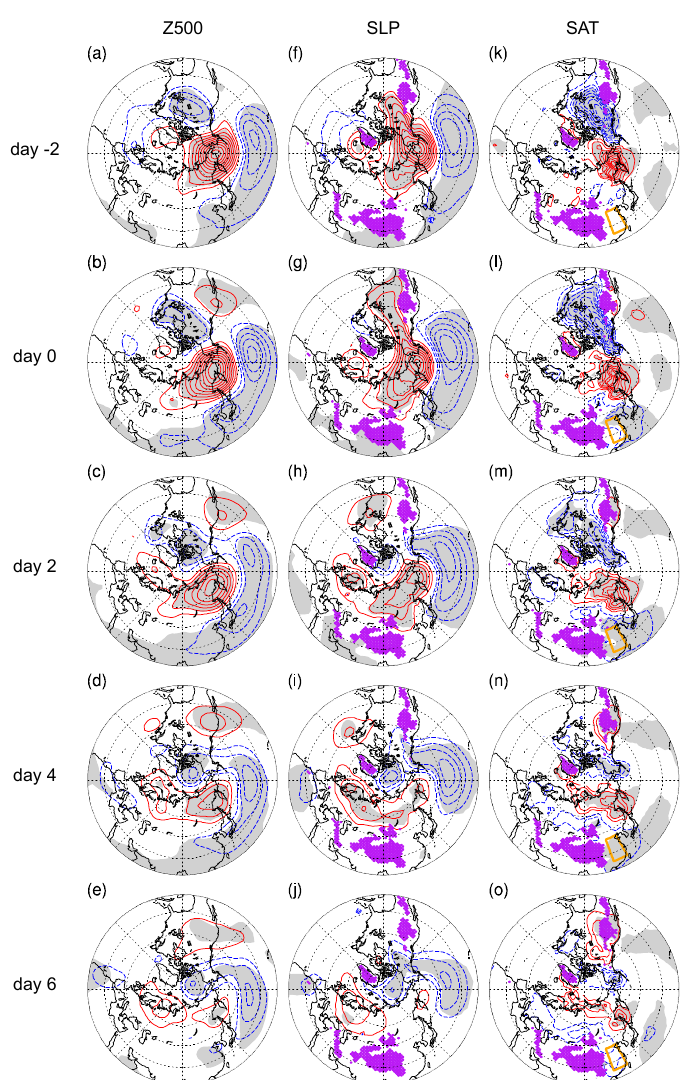
Figure 4. Composites of anomalous Z500 (first column), sea level pressure (SLP) (second column), and SAT (third column) for 61 positive WP events. Shading denotes significant anomalies, based on two-tailed Student’s t test controlled by false discovery rates with 𝛼 (cid:2890)(cid:2888)(cid:2902)∗ = 0.05. Threshold values for the significance level 𝑝 (cid:2890)(cid:2888)(cid:2902)∗ are 0.008, 0.007, and 0.005 for the composites of anomalous Z500, SLP, and SAT, respectively. Contours are drawn for ( a – e ) ± 25, ± 50, … gpm; ( f – j ) ± 2, ± 4, … hPa; and ( k – o ) ±0.5, ±1, … K. Solid red and dashed blue lines represent positive and negative anomalies, respectively. Purple stippling indicates topographic height exceeding 1500 m. Orange rectangles in third column represent southern China.